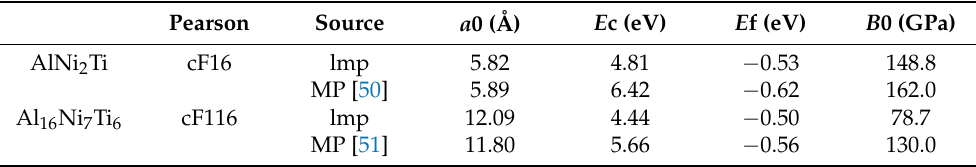
Table 4. Properties of Al-Ni-Ti compounds used for fitting and the reproduced results: lattice constants ( a 0), cohesive energy ( E c), formation energy ( E f) and bulk modulus ( B 0). lmp indicates that the data were calculated by LAMMPS, and MP indicates that the data were collected from the Materials